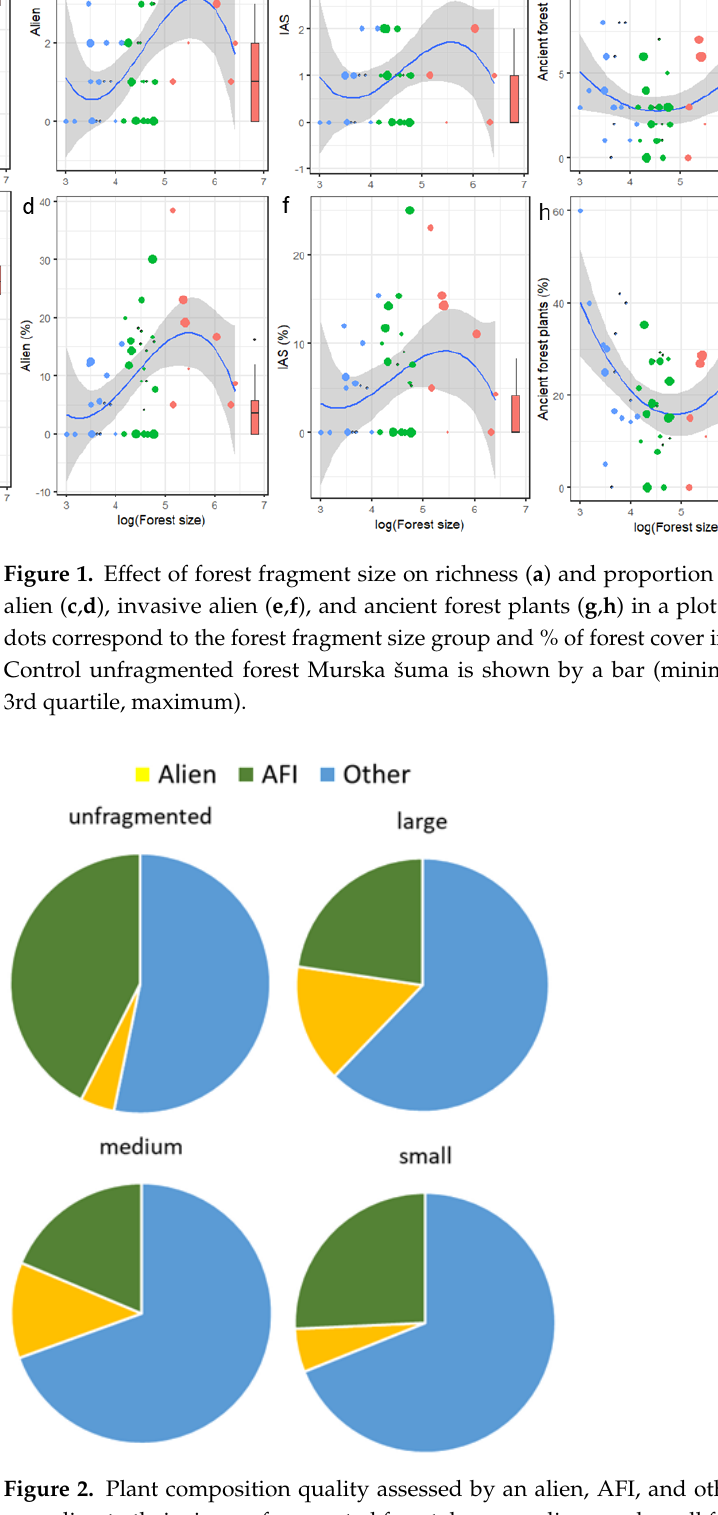
Figure 2. Plant composition quality assessed by an alien, AFI, and other plants in forest groups according to their size: unfragmented forest, large, medium, and small forest fragments.